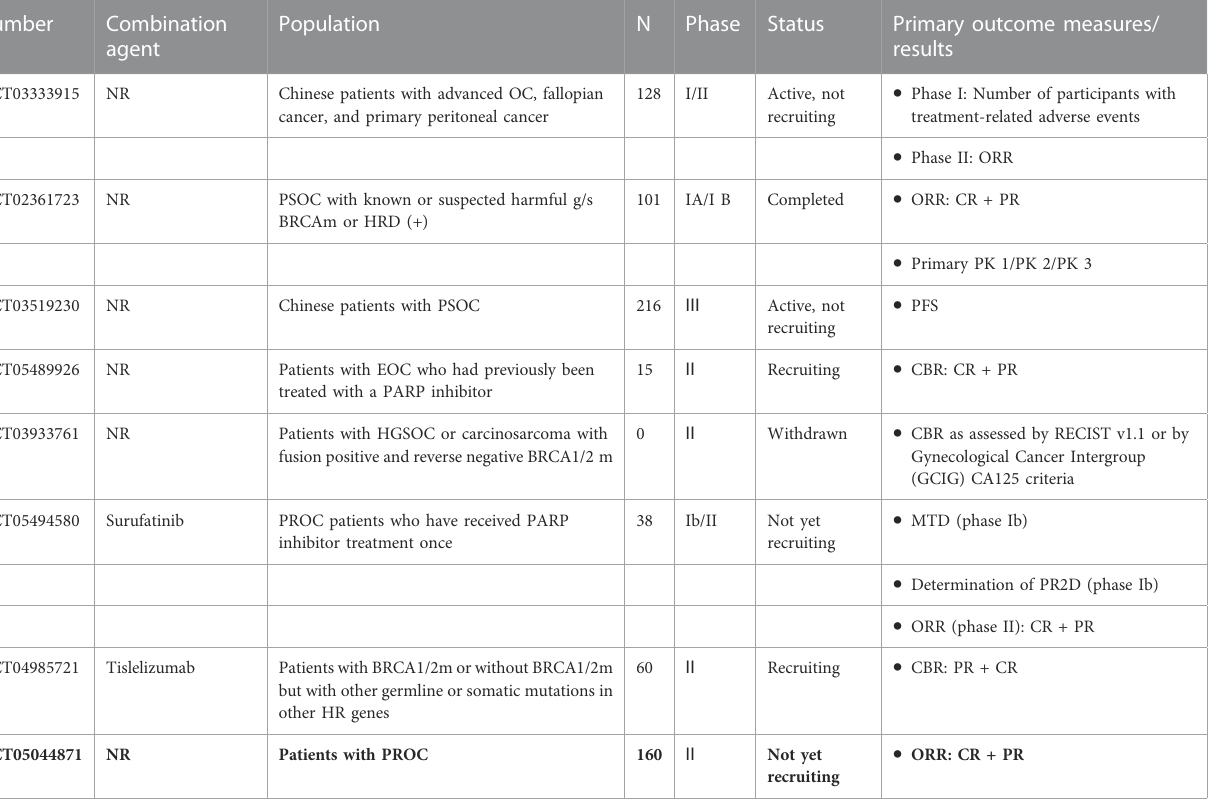
TABLE 2 Summary of clinical trials of parmiparib in the treatment of ovarian